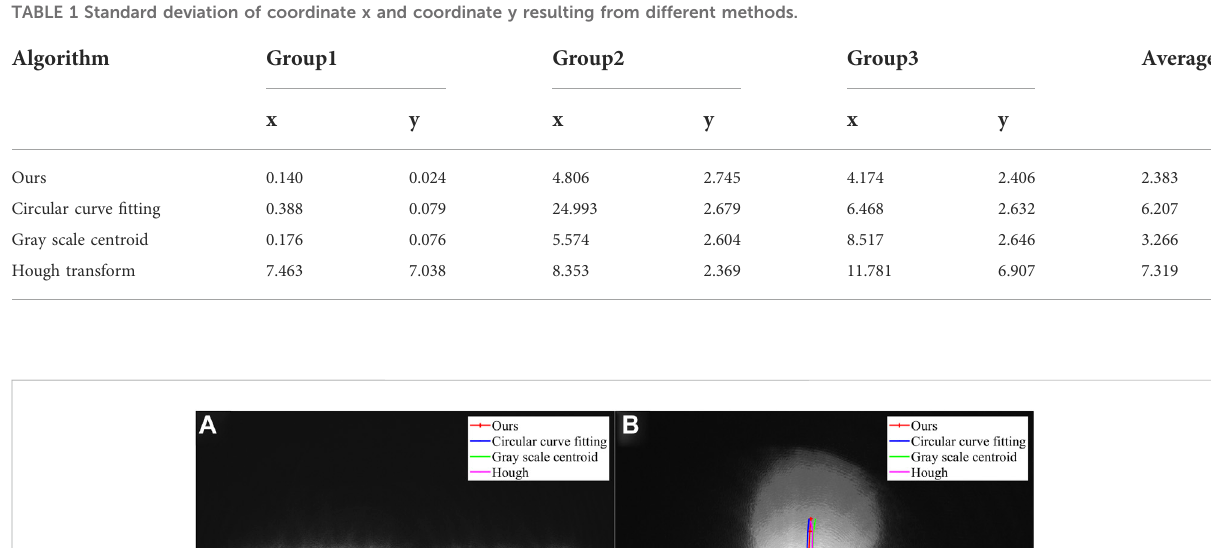
TABLE 1 Standard deviation of coordinate x and coordinate y resulting from different methods.